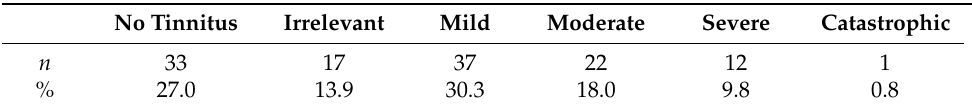
Table 5. Distribution of the participants along the THI categories. No Tinnitus Irrelevant Mild Moderate Severe Catastrophic n 33 17 37 22 % 27.0 13.9